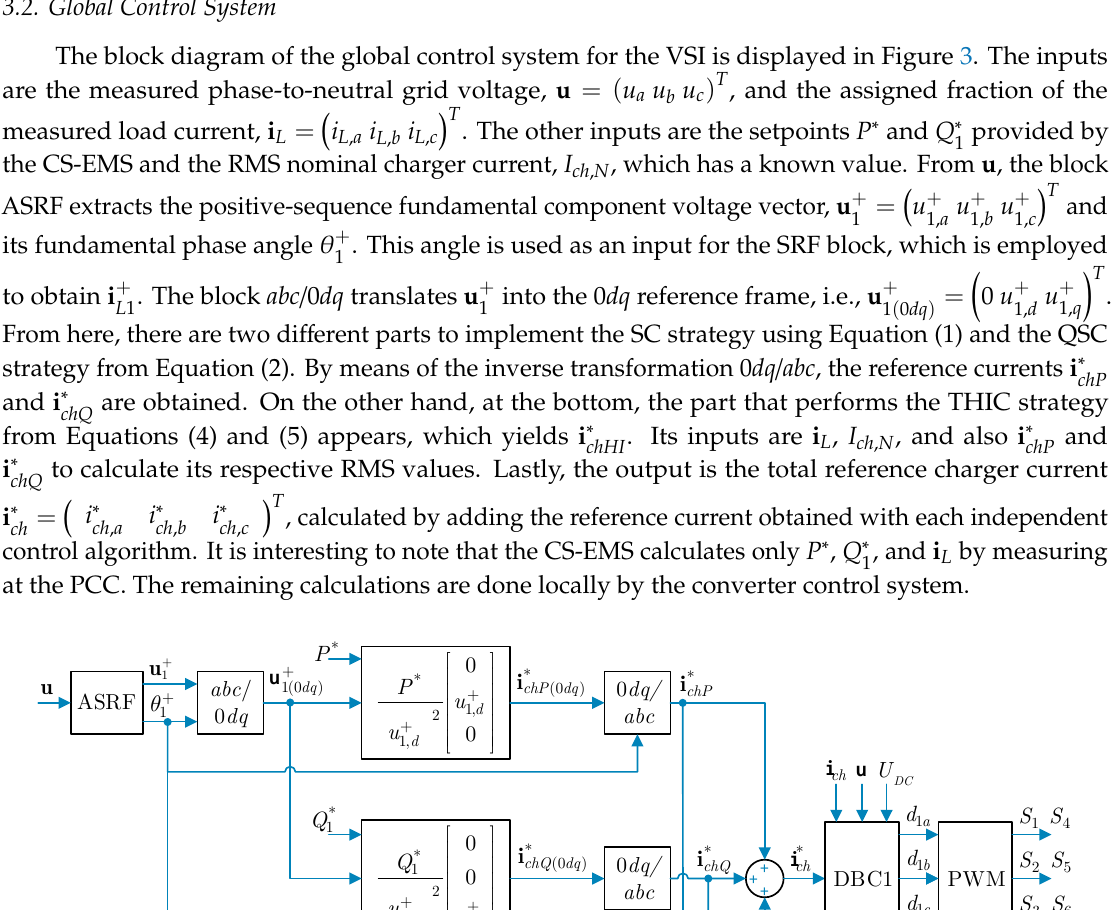
Figure 4 . Block diagram of the bidirectional DC/DC converter control strategy. Dead-beat controllers are used to generate the switching signals of the converters, by trying to reduce to zero the difference between the reference and measured currents at the end of each switching period 𝑇 𝑆 . For each converter leg, 𝑇 𝑂𝑁 is defined as the time interval while the upper switch of that leg is in the on-state (the operation of the two switches of one leg is complementary, so the bottom switch is in the off state) and its duty cycle d as the relation 𝑑 = 𝑇 𝑂𝑁 /𝑇 𝑆 . According to Reference [25], the duty cycle 𝑑 1𝑖 ( i = a , b , c ) necessary to achieve the measured variable 𝑖 𝑐ℎ,𝑖 to be equal to the reference value 𝑖 𝑐ℎ,𝑖∗ at the end of the switching period 𝑇 𝑆 for the i- leg of the VSI is obtained from the equation below. 𝑑 1𝑖 = (𝑢 𝑖 + 𝑈 𝐷𝐶 2⁄ )𝑇 𝑆 − (𝑖 𝑐ℎ,𝑖∗ − 𝑖 𝑐ℎ,𝑖 )𝐿 1 − 𝑖 𝑐ℎ,𝑖 𝑅 1 𝑇 𝑆 𝑇 𝑆 𝑈 𝐷𝐶